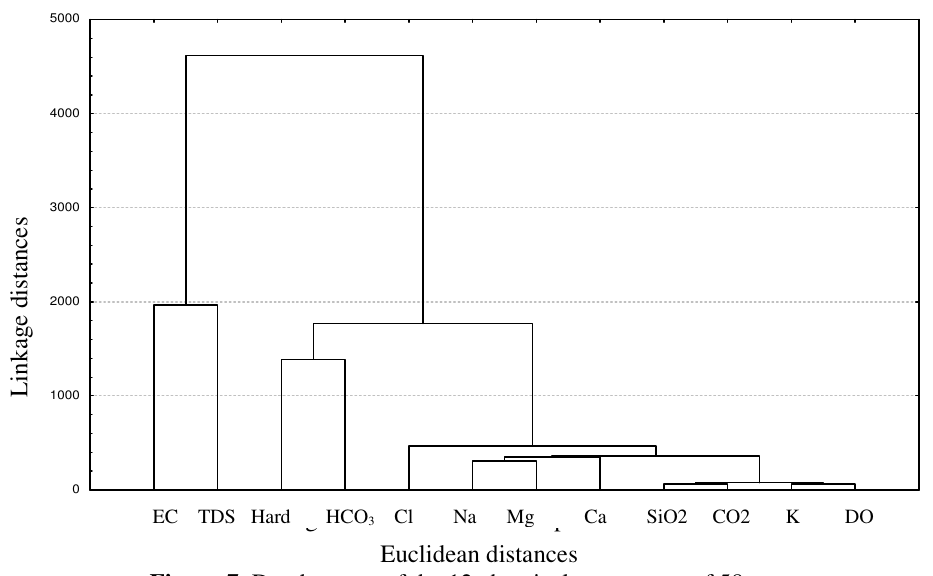
Figure 6. Dendrogram of the location of 58 cases using single linkage